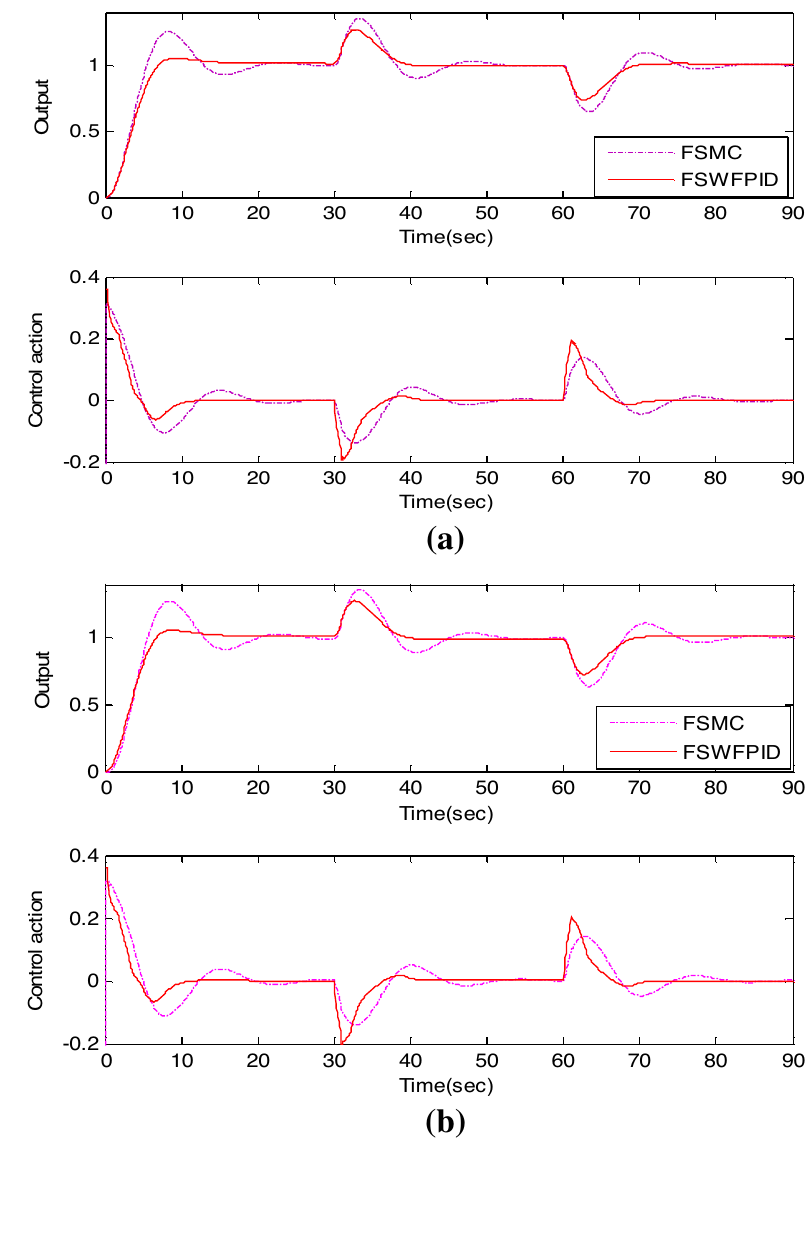
Fig. 22 Comparison among responses and control actions for Model V with FSMC using 49 rules during set point response and with load varia- tion for a L = 0.2 s, b L = 0.3